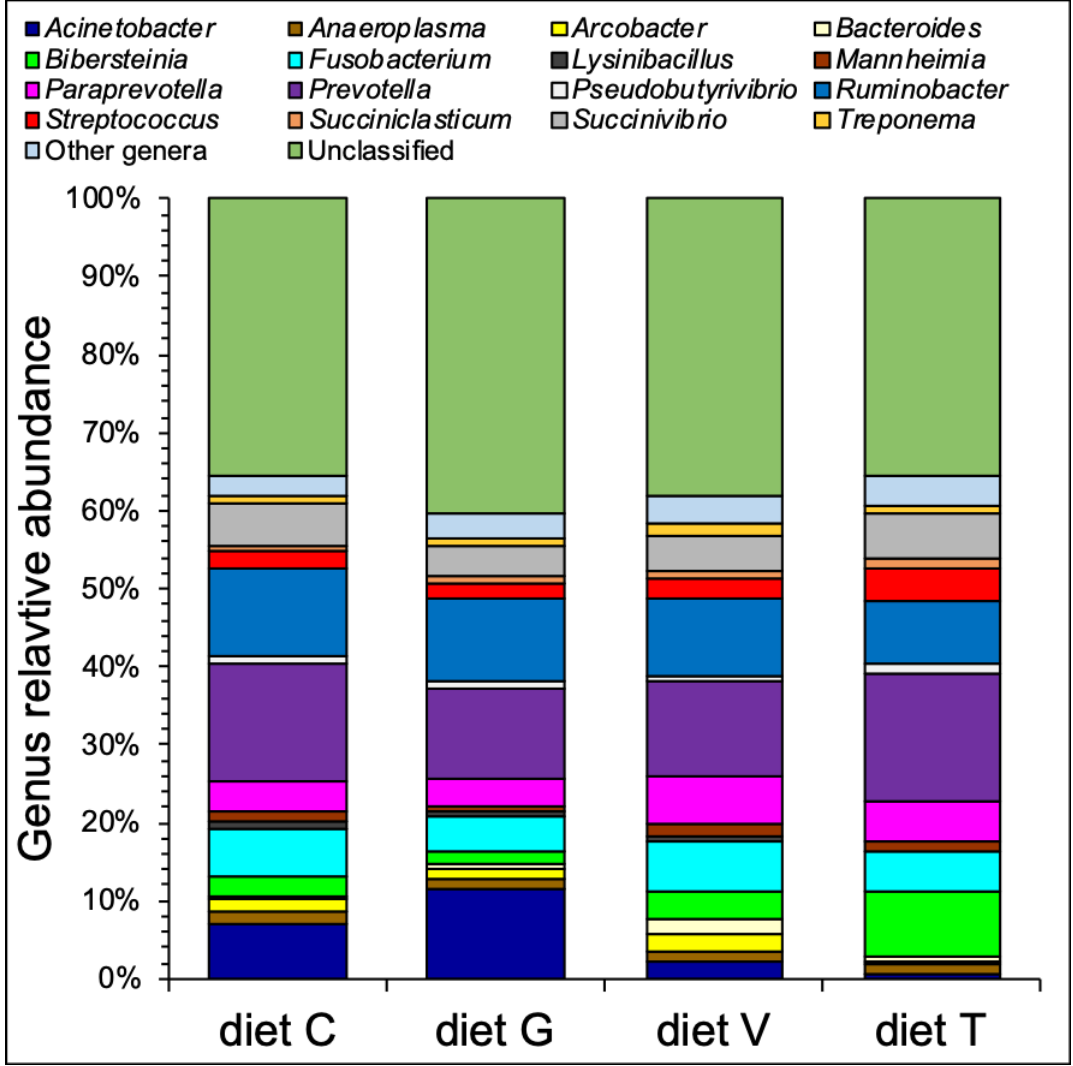
Figure 1. Taxonomic composition at genus level of the microbial communities enriched during the in vitro trial. Average abundances are reported for each tested condition. Only the genera with an average relative abundance of 1% (or higher) in at least one condition are reported.